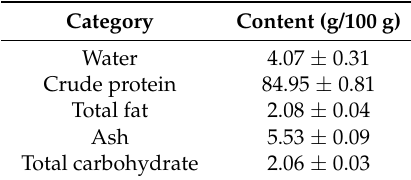
Table 1. Composition of sheep placental extract. 1